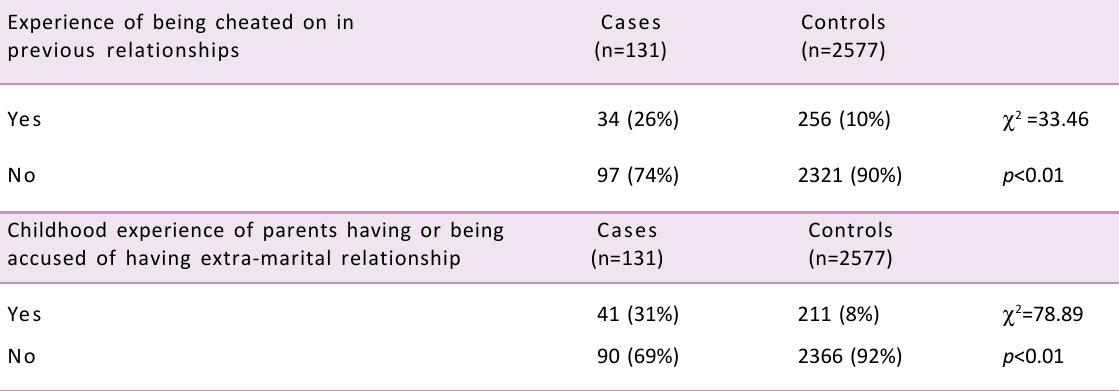
Table 2. Association between experience of being cheated on in previous relationships or childhood experience of parents having or being accused of having extra-marital relationship and morbid jealousy Experience of being cheated on in Cases Controls